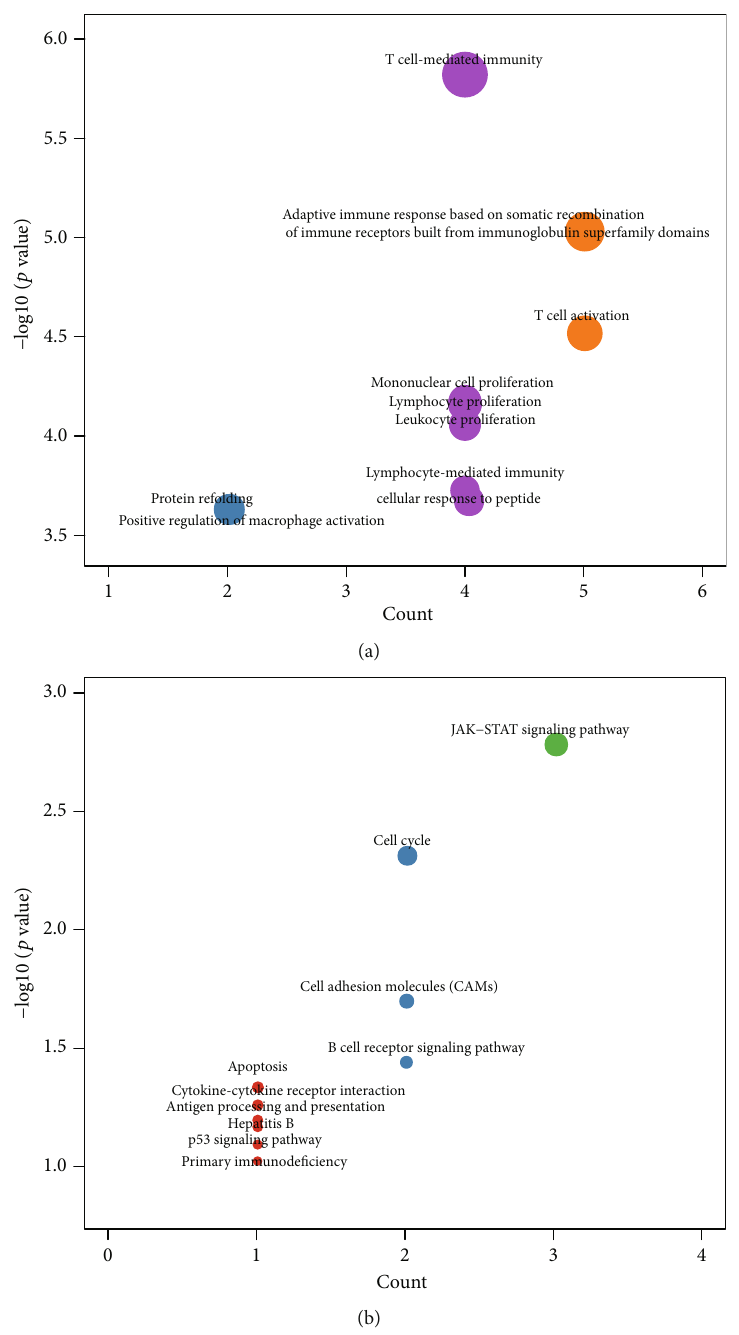
Figure 7: Functional analysis of the nine-IRGP signature. Biological function of the nine-IRGP signature for (a) GO and (b) KEGG